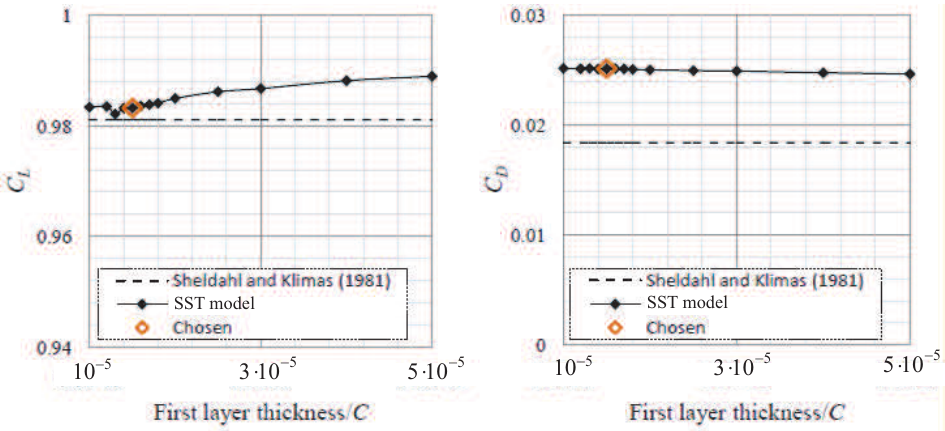
Figure 9. Variation in lift and drag as a function of first layer thickness ( α = 10 ◦ , Re = 3.6 × 10 5 ).